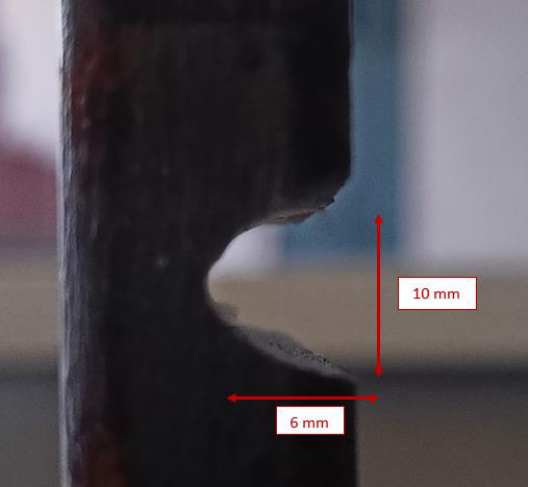
Figure 4. A sample of damage introduced to the building